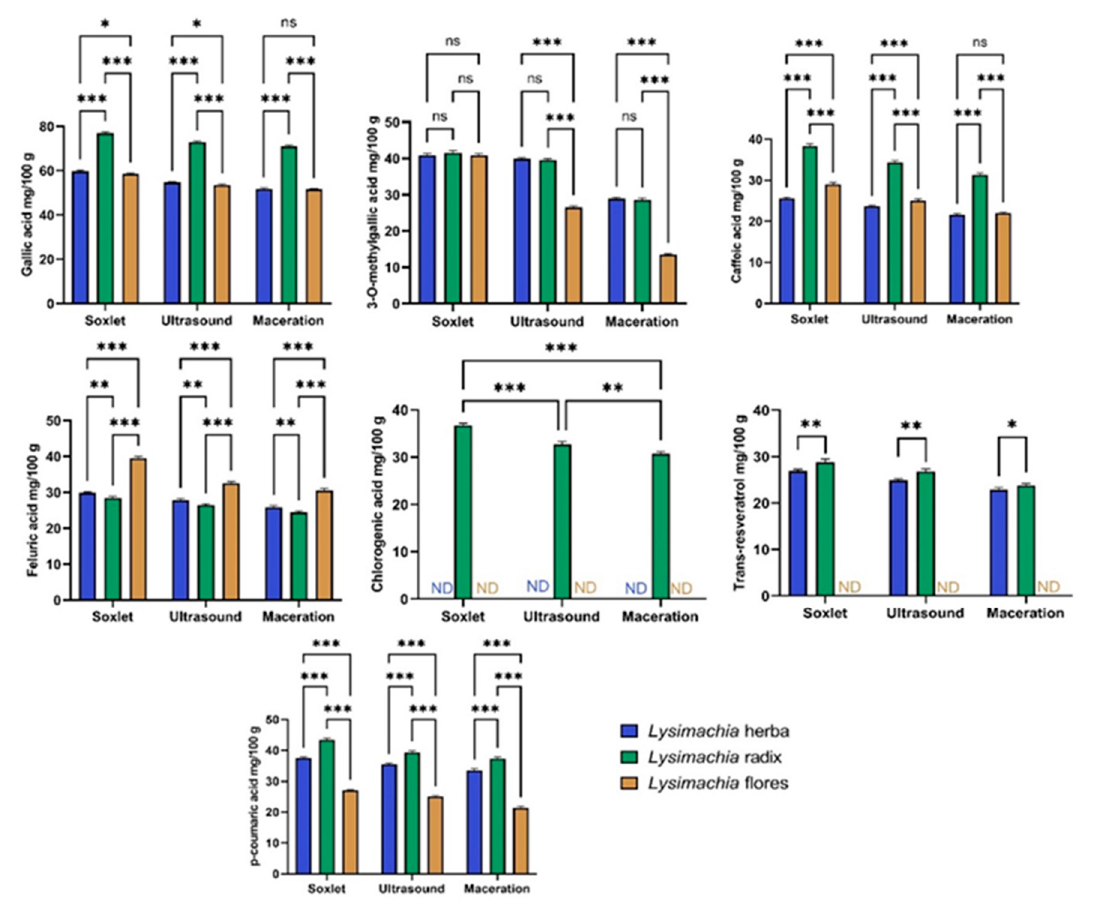
Figure 6. Gallic, chlorogenic, 3- O -methylgallic, p-coumaric, caffeic and ferulic acids and trans - resveratrol in Lysimachiae nummularia L. ethanolic 70% ( v/v ) extracts. The concentrations of phenolic compounds in the ethanolic extracts are expressed in mg/100 g dry sample. The results are presented as mean and error bars ( n = 5). Asterisks indicate the statistical significance examined by Tukey test for multiple reciprocal comparison among the extracts (significant: * p < 0.05, ** p < 0.01, *** p < 0.001, ns: p > 0.05).